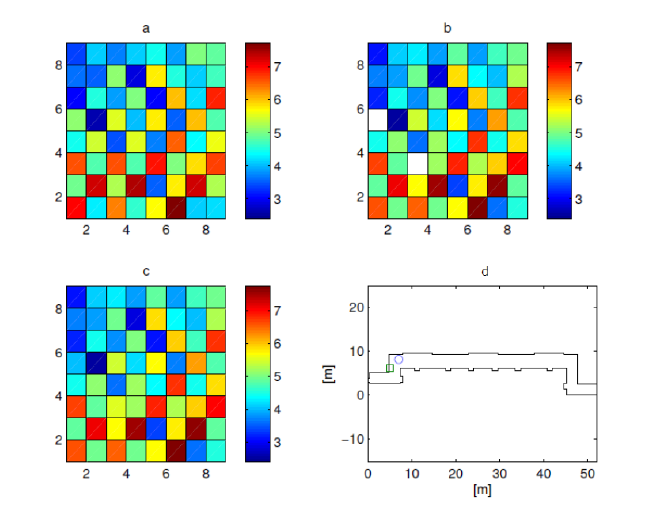
Figure 7. 9 × 9 MIMO system in a corridor; amplitude of the exact (noise-free) ( a ), measured ( b ) and estimated ( c ) channel matrix; ( d ) the geometry of the problem: the position of the transmitting and receiving MIMO systems are plotted as green square and blue circle